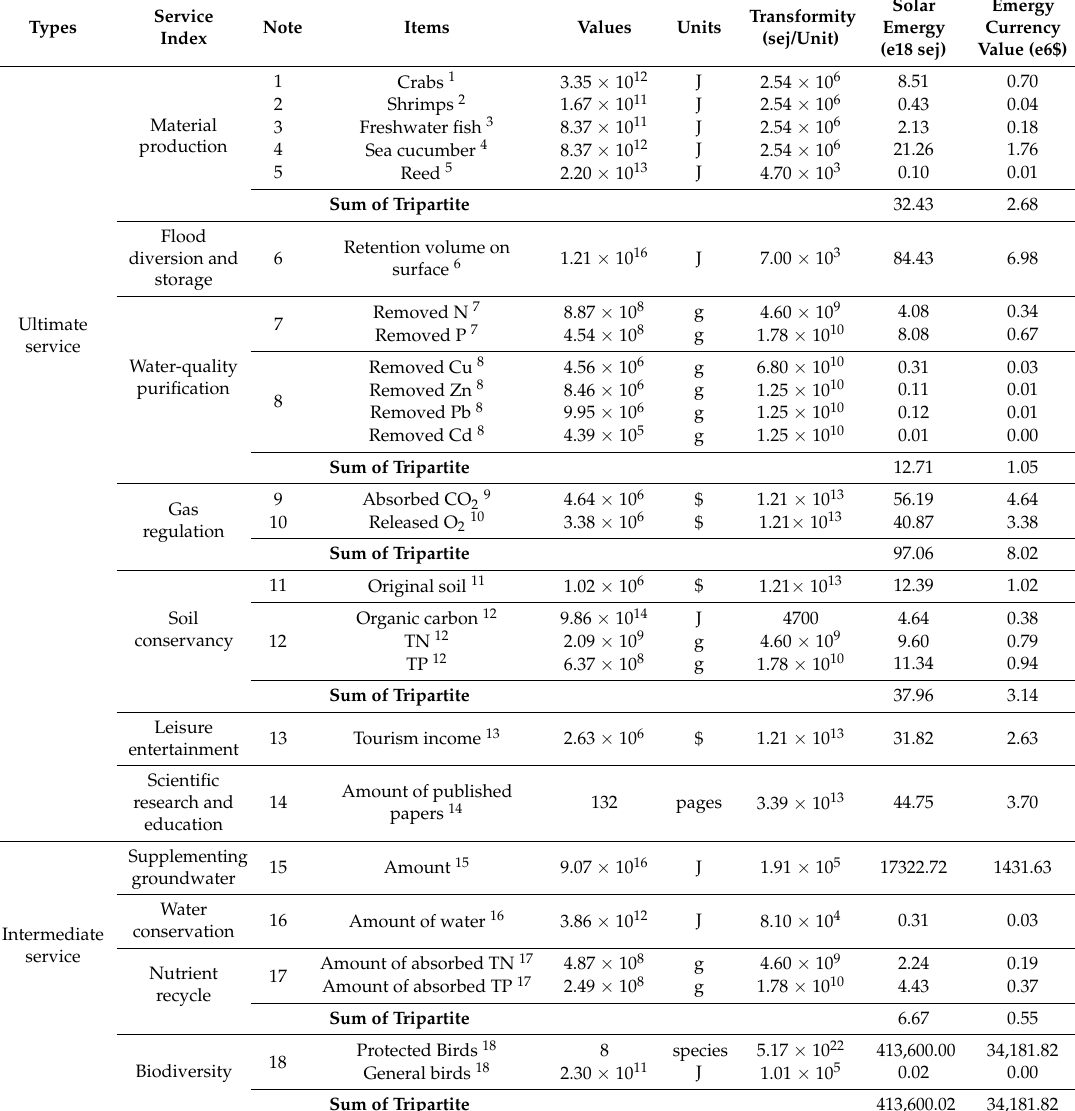
Table 2. Emergy evaluation of the Liaohe estuarine wetland